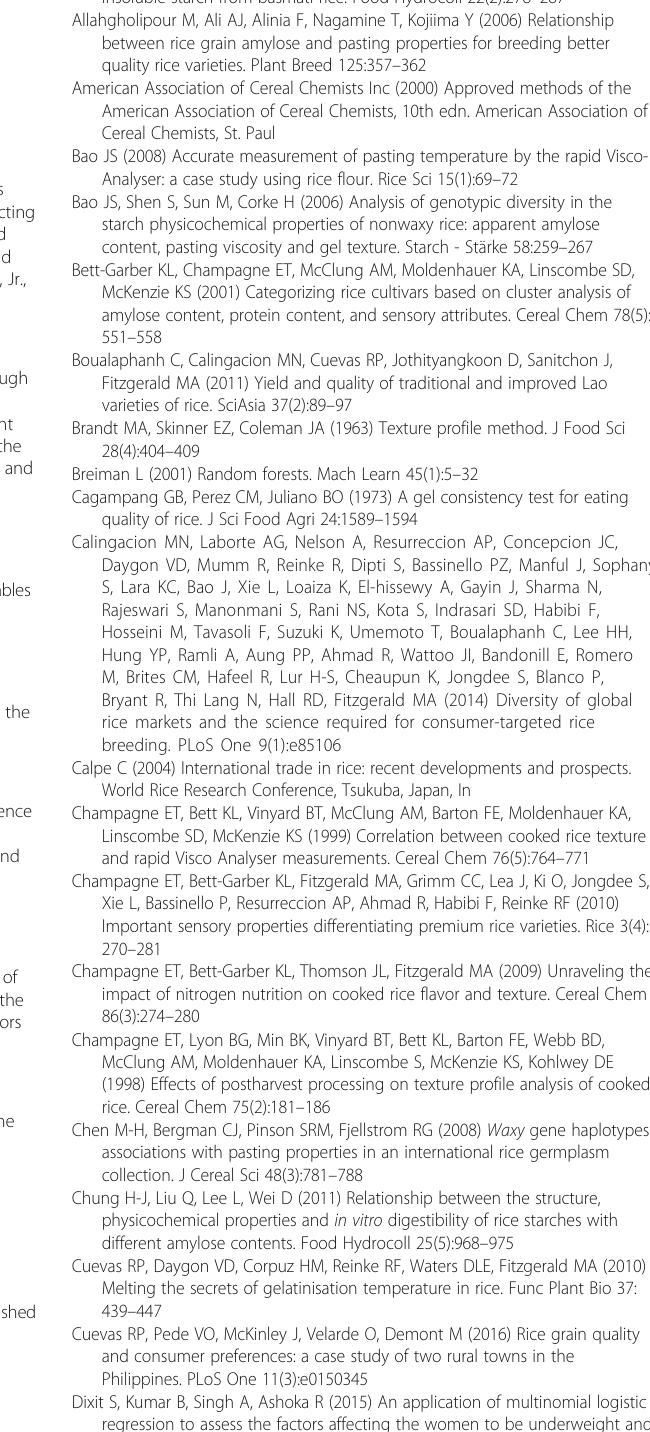
Abbreviations AC: Amylose content; ADH: Adhesiveness; COH: Cohesiveness; DSC: Differential scanning calorimetry; FV: Final viscosity; GT: Gelatinisation temperature; HRD: Hardness; LO: Lift-off; MLR: Multinomial Logistic Regression; PC: Protein content; PV: Peak viscosity; RVA: Rapid Visco-Analysis; SB: Setback; SPR: